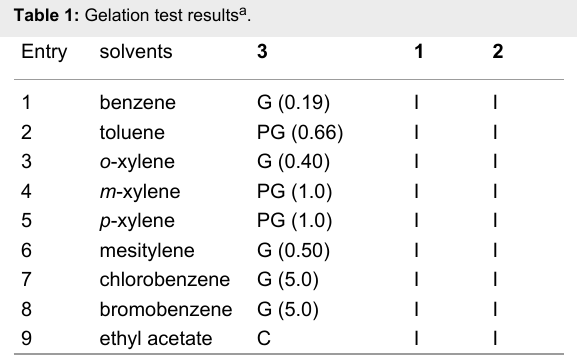
Scanning electron micrographs of the dried gels revealed a fibrous network structure having fibers of submicron diameters (Figure 2a). With increasing concentration of compound 3 , the gel to sol transition temperature ( T gel ) increased indicating an increase in the degree of branching in the fibrillar network (Figure 2c) [17,18].